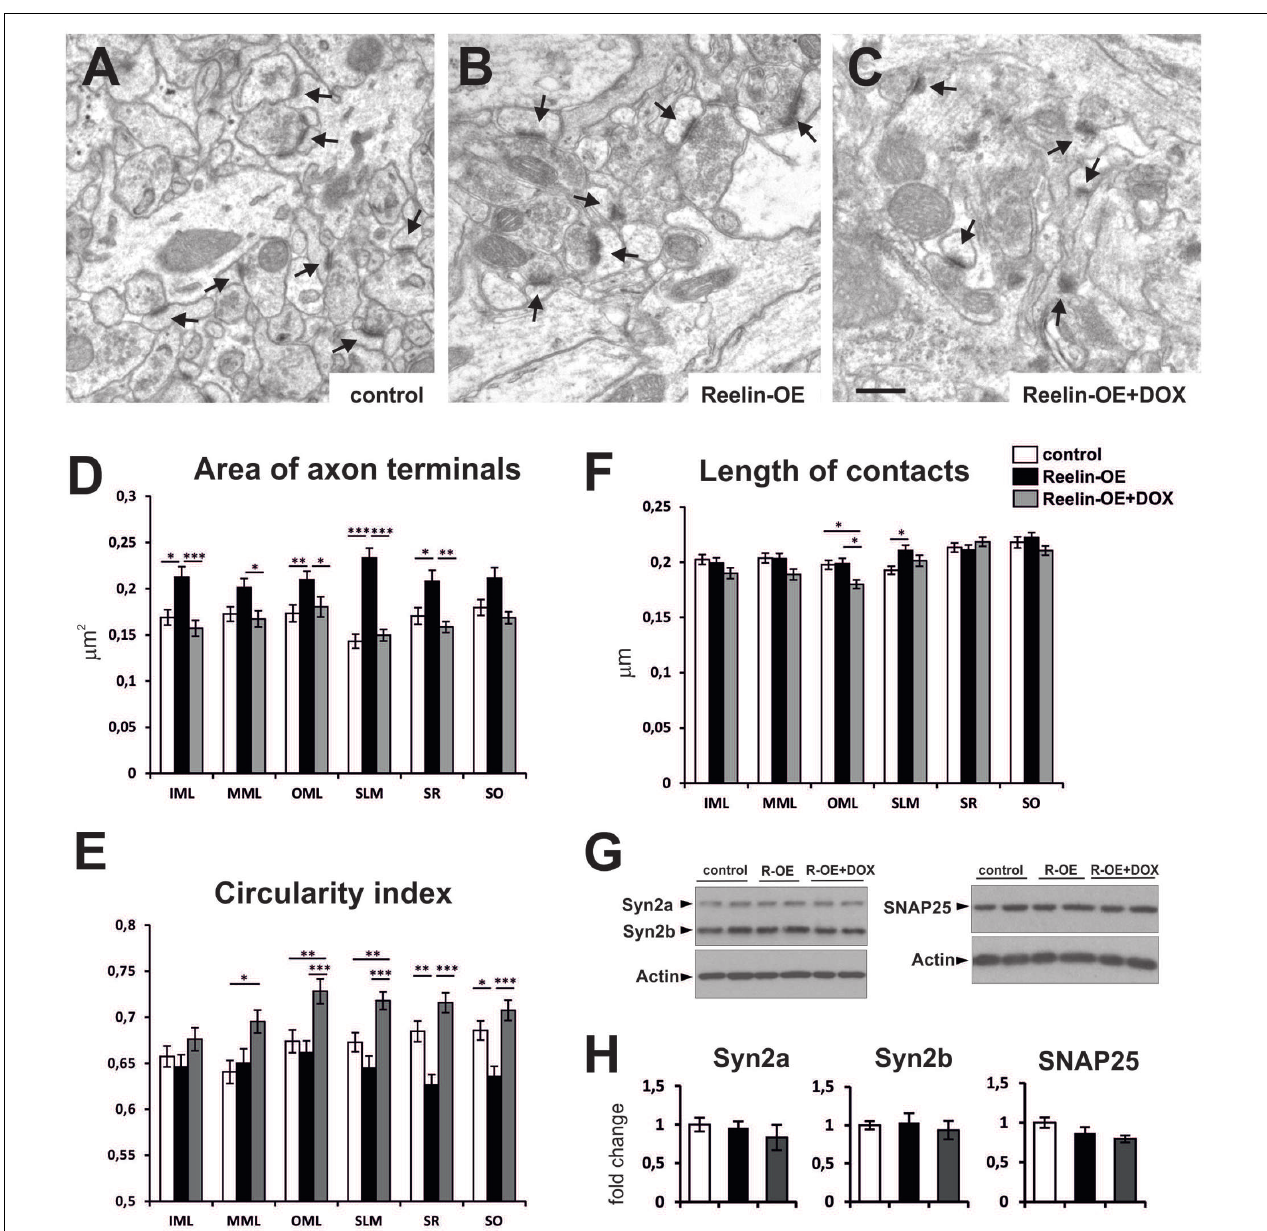
FIGURE 1 | Fine structure and molecular phenotype of axon terminals in Reelin-OE mice. (A–C) Electron micrographs illustrating axon terminals establishing synaptic contacts (arrows) in the inner molecular layer of control, Reelin-OE, and DOX-treated Reelin-OE mice. (D–F) Histograms showing area (D) , circularity index (E) , and length of synaptic contact (F) of axon terminals in different hippocampal layers in control, Reelin-OE, and DOX-treated Reelin-OE mice (mean ± SEM; ∗ p < 0.05, ∗∗ p < 0.01, ∗∗∗ p < 0.001; ANOVA test). (G) Western-blot analysis of a and b isoforms of Synapsin 2, and SNAP25 in synaptosomal fractions of the hippocampus. (H) Quantification of Synapsin 2a, Synapsin 2b, and SNAP-25 values from triplicate experiments. Values are normalized to the levels of actin and expressed as percentage of control mice (mean ± SEM, ANOVA test). IML, inner molecular layer; MML, medial molecular layer, OML, outer molecular layer; SLM, stratum lacunosum-moleculare; SO, stratum oriens; SR, stratum radiatum. Scale bar in (A–C) , 0.5 µ